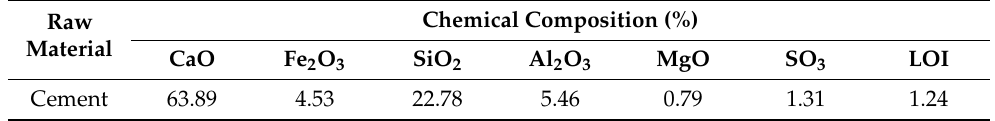
Table 2. The main chemical composition of cement.